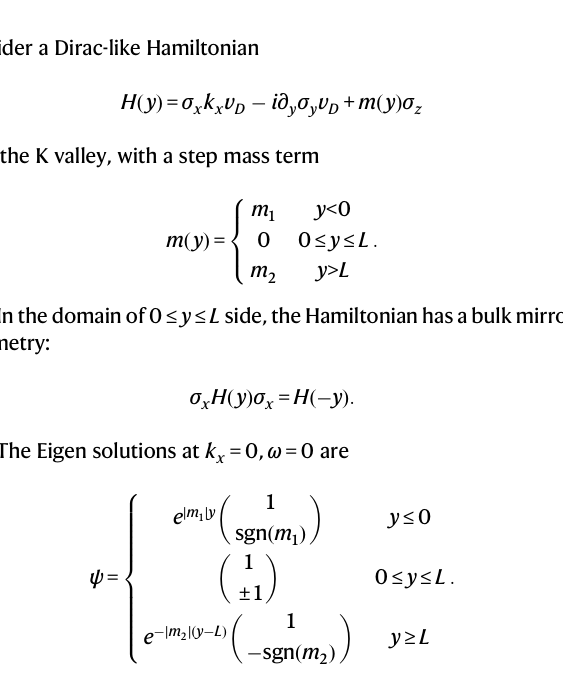
ffiffi p a wide) along the y - 3 2